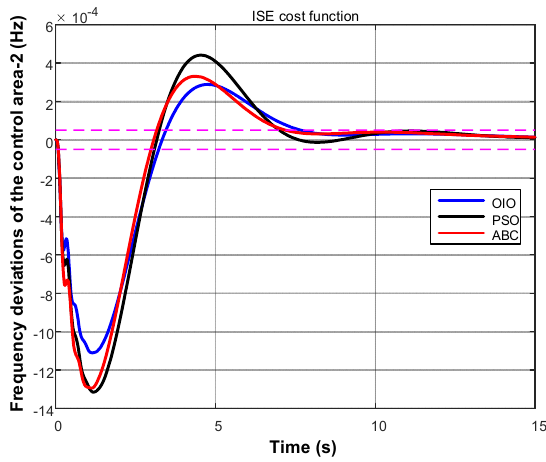
Figure 8. Change in frequency of area ‐ 2 for IAE.